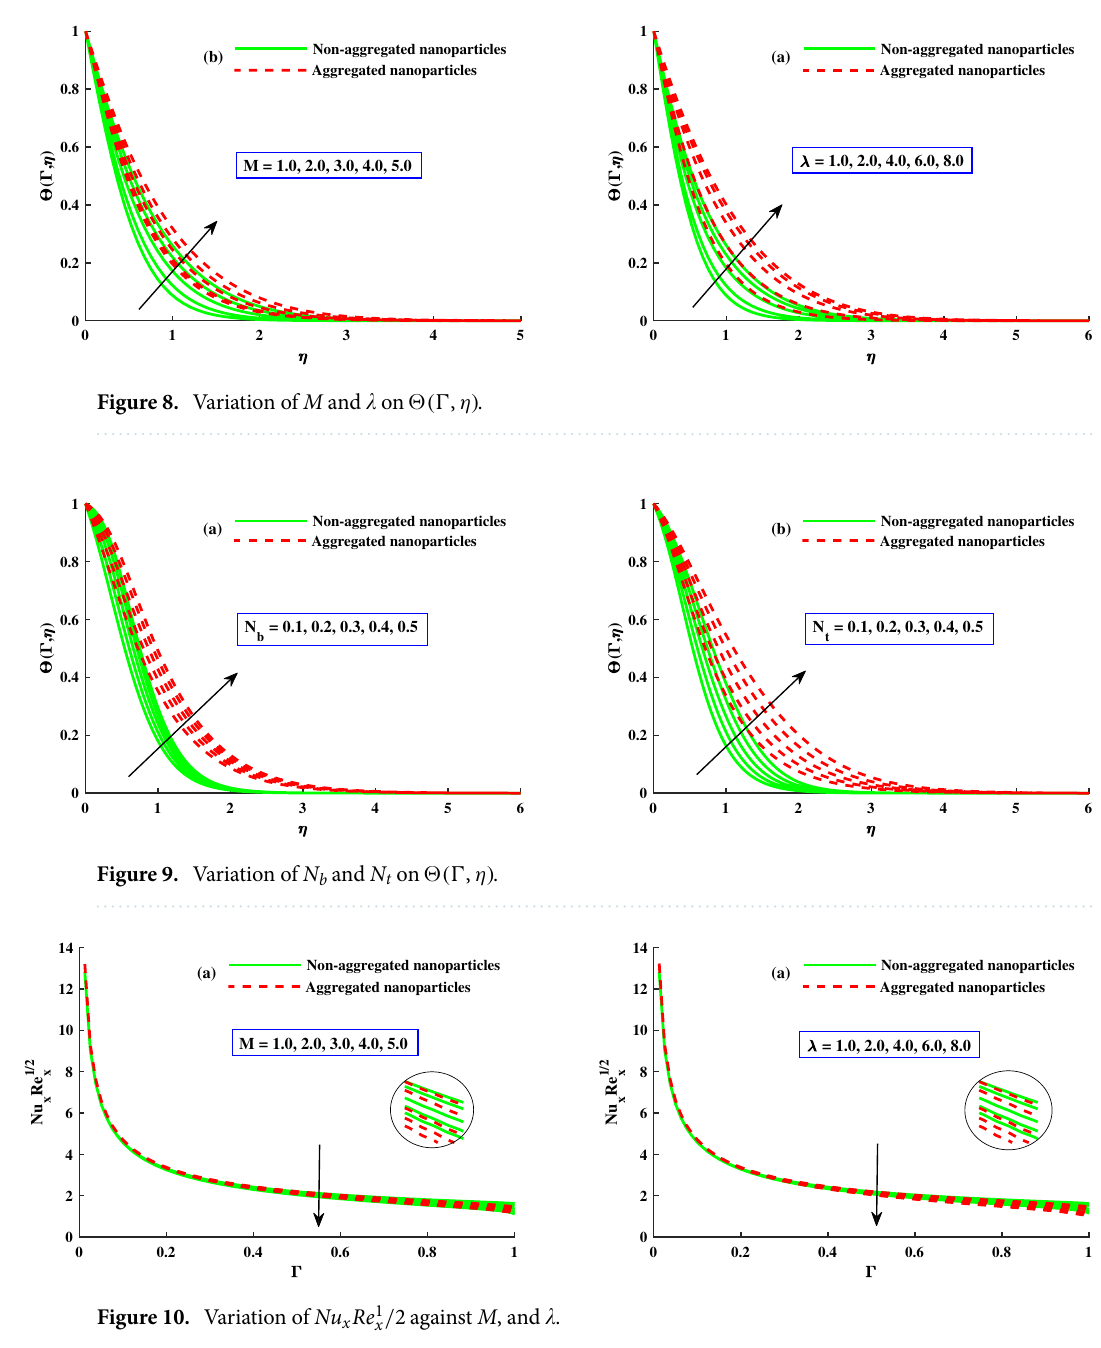
Figure 10. Variation of Nu x Re 1 x / 2 against M , and (cid:31)